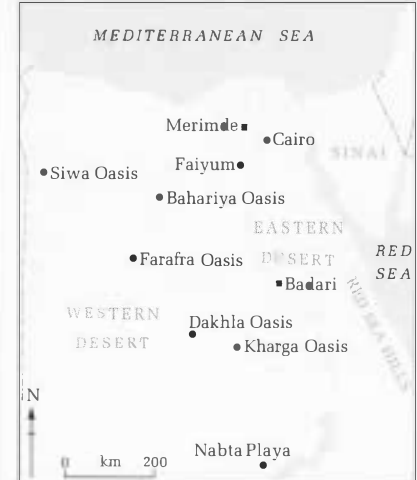
Figure 1 The location of Farafra and other major oases of Egypt's Western Desert, part of the eastern Sahara.